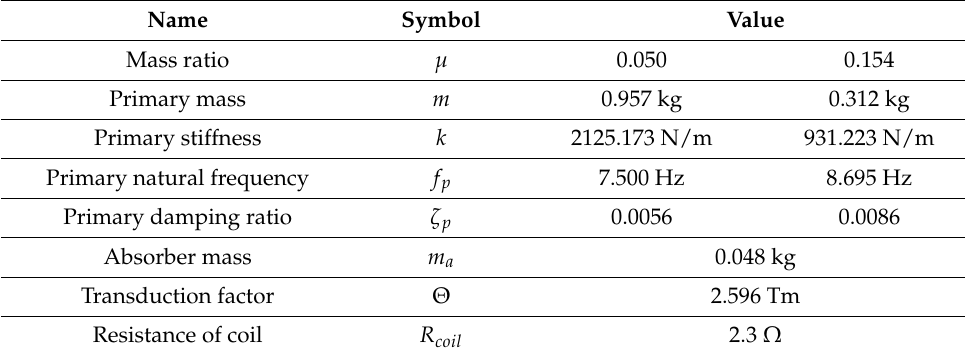
Table 6. Different beam lengths and their corresponding frequency tuning